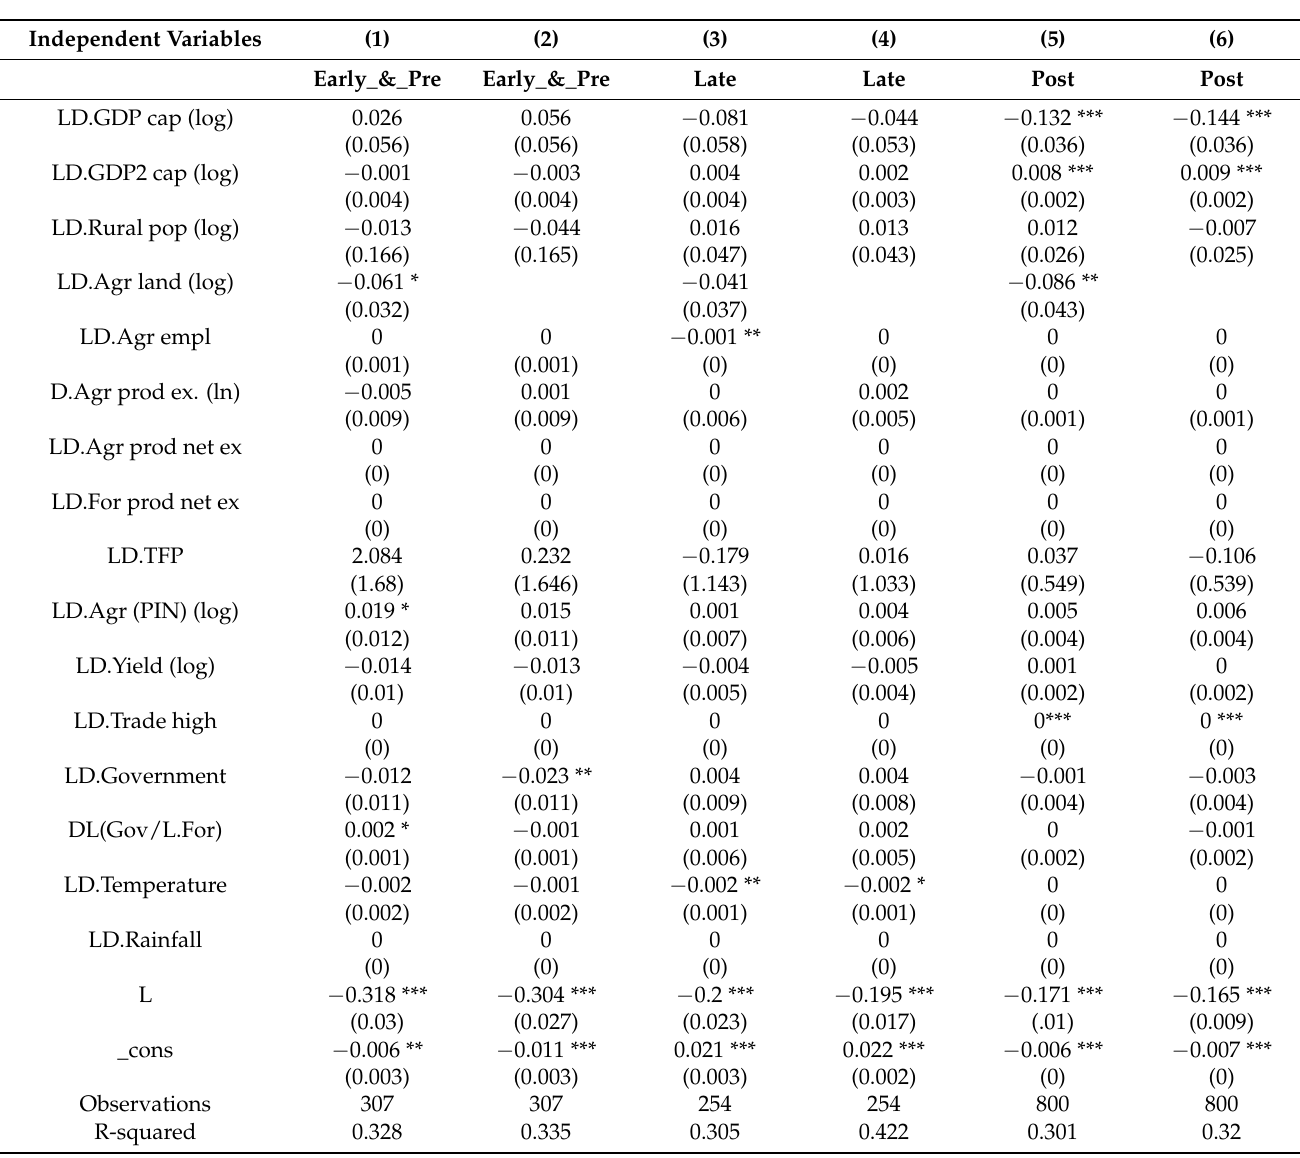
Table A9. Short run, forest transition clusters, net agricultural exports and net exports of forests products as additional control